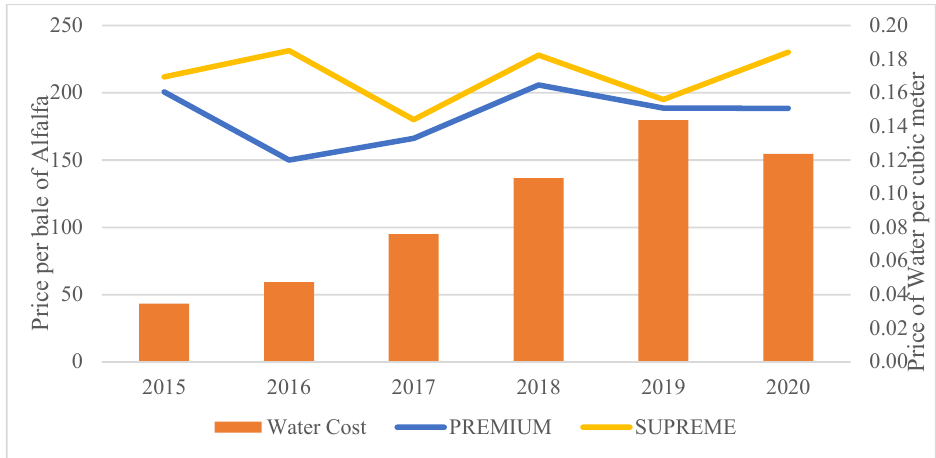
Figure 9. Alfalfa hay prices from 2015 to 2020 in Northeast Colorado showing supreme and premium feed quality price differences. Data from USDA Department of Ag Market and price for one cubic meter from 2015 to 2020, from Northern Water Pool Bids.